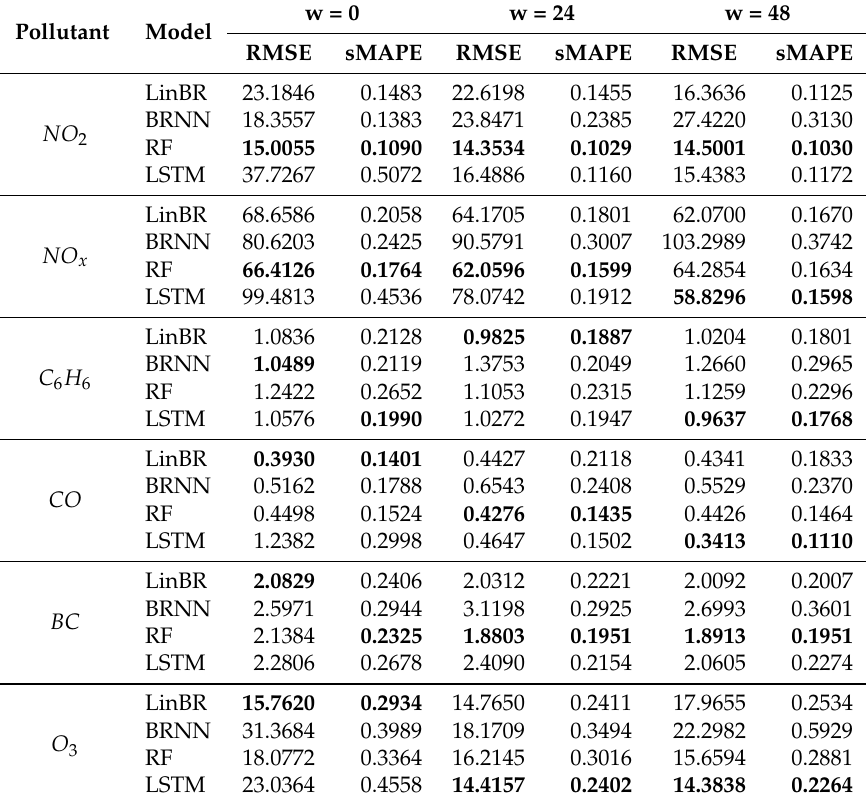
Table 6. Results of the adopted models on the Hourly Set. For each pollutant and model, RMSE and sMAPE metrics are provided, in three different scenarios: no lag, 24-h, and 48-h windows. Results highlighted in bold represent the best performing model w.r.t the pollutant and the window w